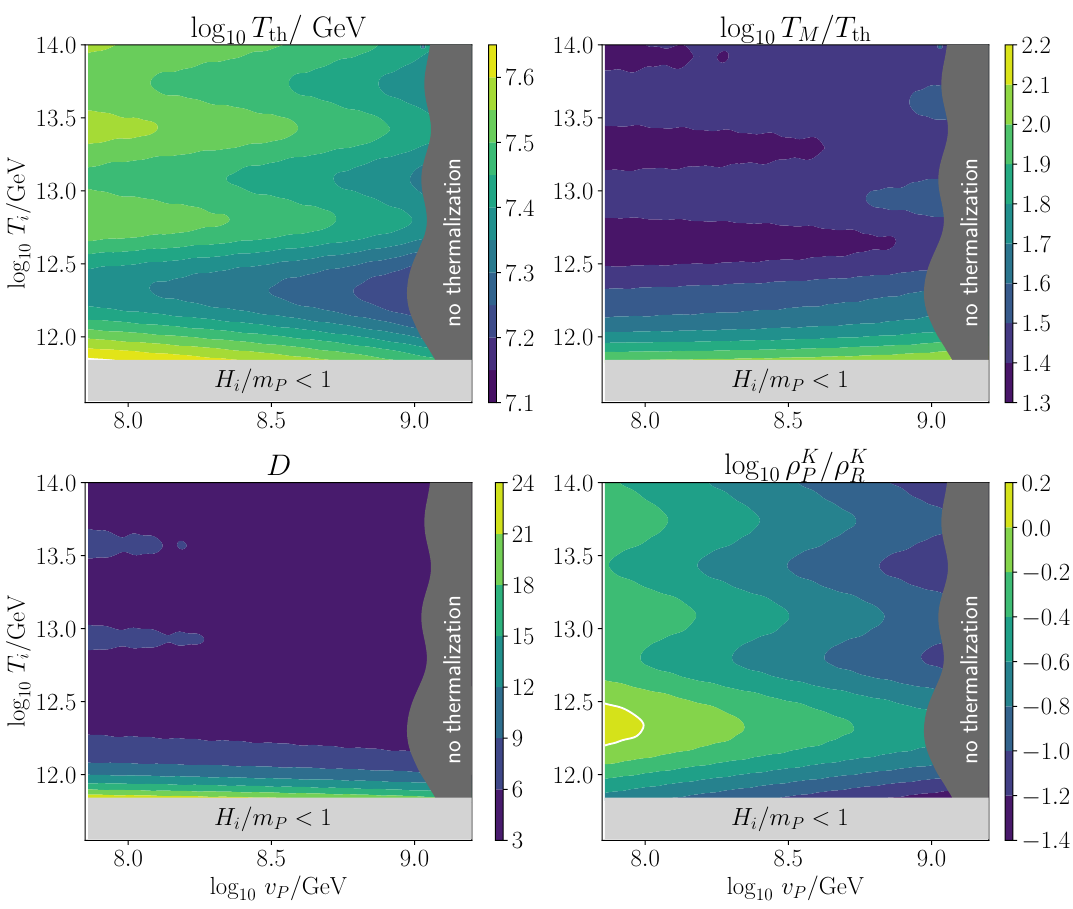
(bottom- Figure 4 . The values of T th (top-left), T M /T th (top-right), D (bottom-left) and ρ K /ρ K P R right) in the case of n = 10 , θ = π/ 20 , and m = 10 6 GeV . i P temperature, where ∆ = 10 , is O (cid:0) 10 7 GeV (cid:1) as expected from our estimation eq. (3.11). It should be noted that this is the temperature when the thermalization completes, and the thermalization itself occurs slightly before this time. We can see this from figure 3, the radiation energy is non-adiabatic at 11 . 5 . u . 13 and is before u = u ∼ 13 . 5 . th Hence, e.g. ∆ N is dominantly produced around u . 13 and the typical temperature is eff effectively higher than T . The thermalization does not complete in the dark gray region th at v & 10 9 GeV, i.e. ∆( u ) < 10 in this region. The PQ field reaches its minimum value P K too early, before thermalization completes, if v is too large. In the top-right panel, the P ratio of T to T is shown. The ratio is at most O (100) for T & 10 12 GeV, and, in this i M th case, the MD era does not last such a long time. The dilution factor D is shown in the bottom-left panel. D ∼ O (10) reflecting the short MD era at T & 10 12 GeV, while it can be larger for lower T . The ratio of the PQ field to radiation energy at u = u is shown in the i K bottom-right panel. The PQ field energy is smaller than the radiation energy throughout the figure, except for the small region where v . 10 8 GeV and T ∼ 10 12 . 3 GeV. i P